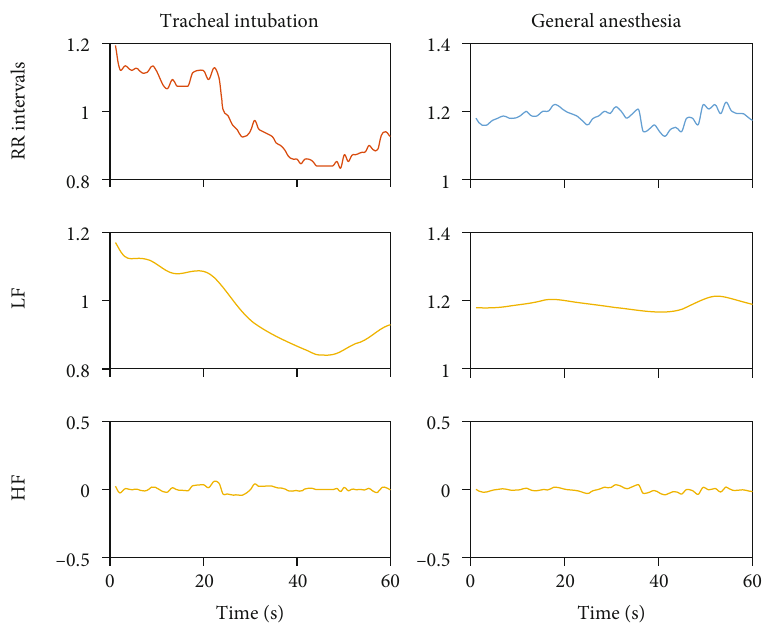
Figure 2: The original RR intervals, the HF component, and the LF component separately form two feature signals corresponding to autonomic nervous system